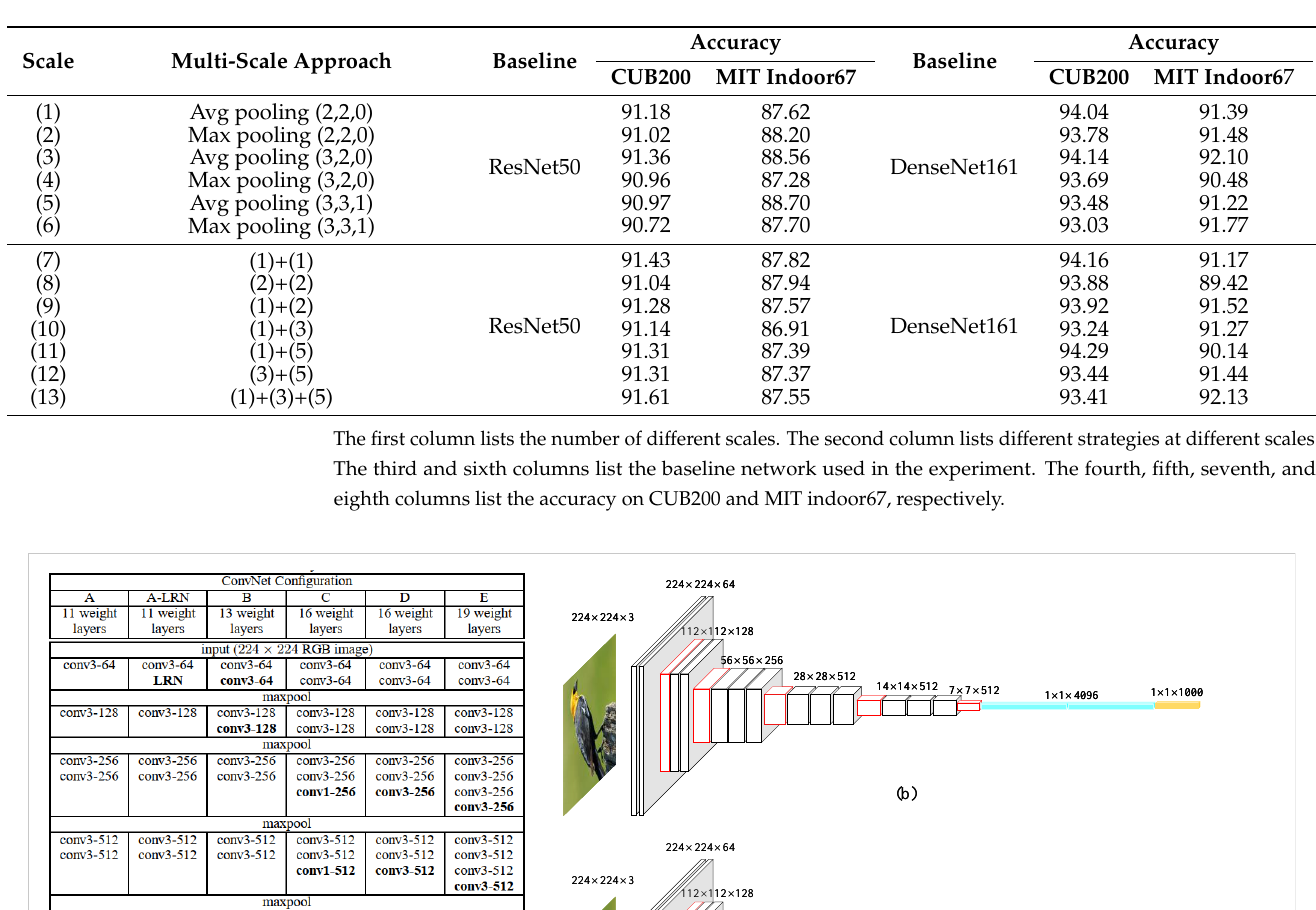
Table 3. Classification accuracy on CUB200 and MIT indoor67 for MSiSQRT-COV.